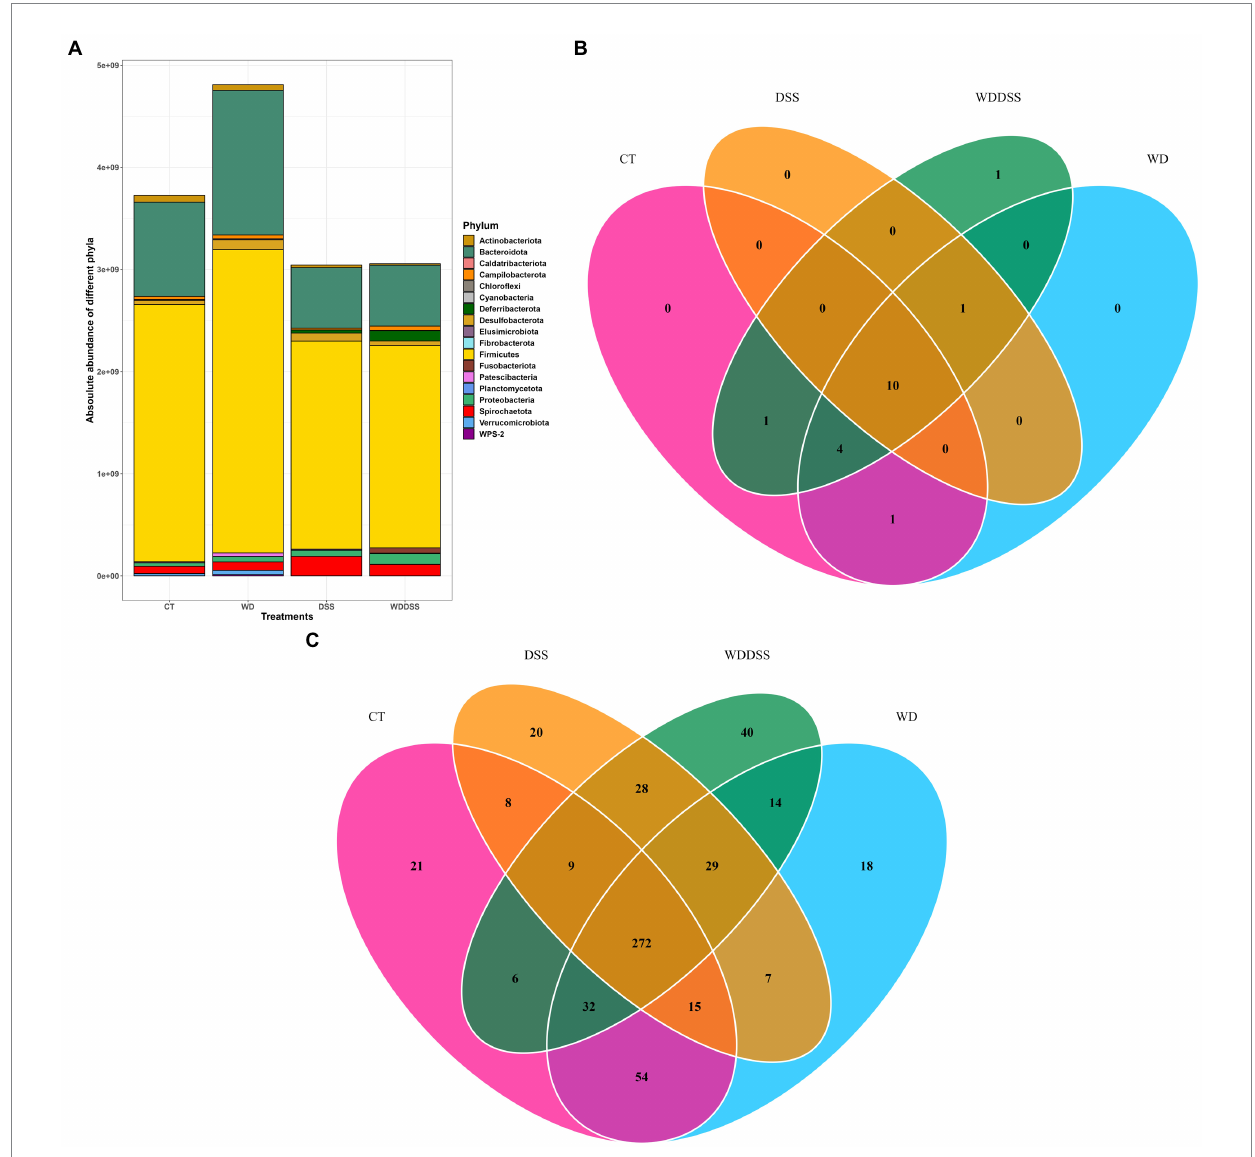
FIGURE 2 Absolute abundances of different phyla with total abundance across all sequence reads in different treatments (A) . The number of different phyla present in the treatment groups was 16, 16, 11, and 17 for CT, WD, DSS, and WDDSS (WD + DSS), respectively. Venn diagram of shared taxa between different treatments at Phylum (B) and Species (C)